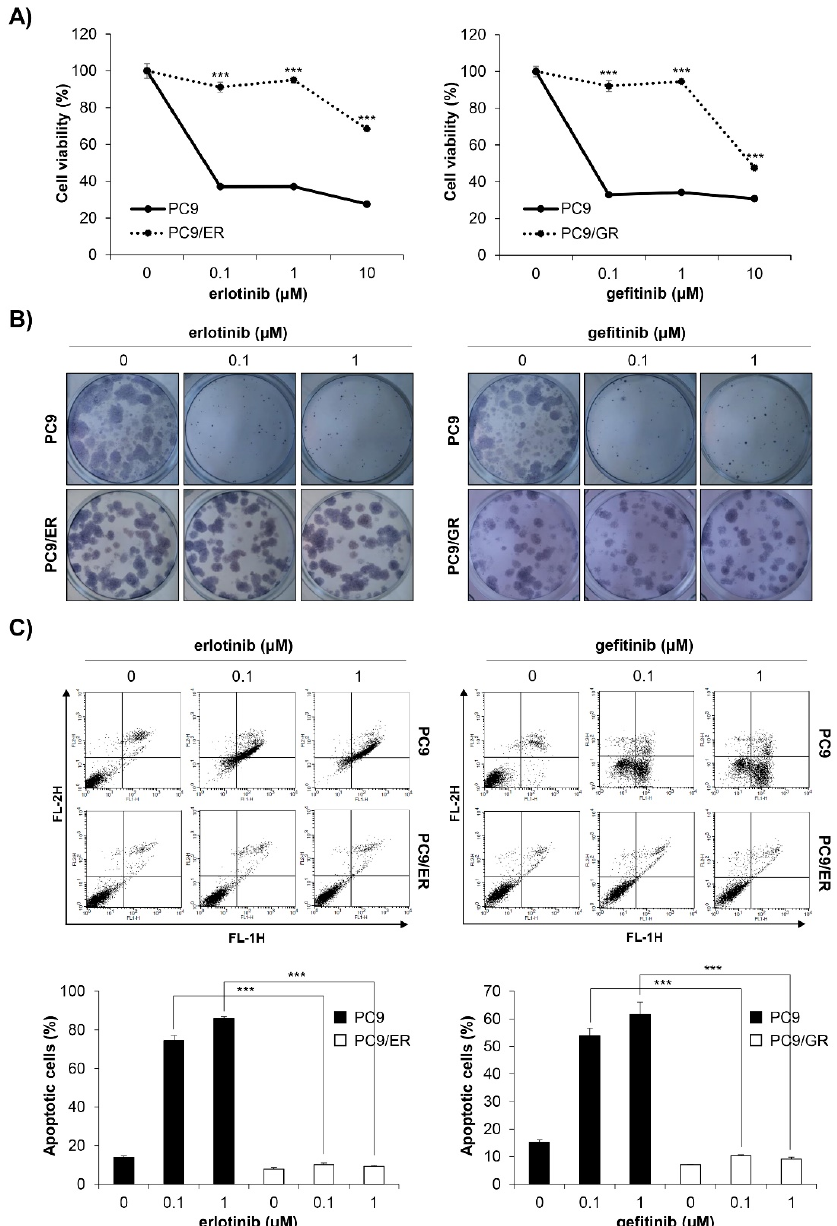
Figure 2. Establishment of PC9/ER and PC9/GR human NSCLC cell lines. ( A ) EGFR TKI-sensitive PC9, acquired erlotinib-resistant PC9/ER, and acquired gefitinib-resistant PC9/GR human NSCLC cell lines were treated with various concentrations of erlotinib (left panel) or gefitinib (right panel) for 72 h. The cell viability was measured by the MTT assay. ( B ) The cells were seeded as a single cell suspension onto 12-well plates and treated with different concentrations of erlotinib (left panel) or gefitinib (right panel) for 10 days. The colonies were photographed using a digital camera (upper panel) and the number of colonies was counted using ImageJ software (lower panel). ( C ) The cells were treated with the indicated concentrations of erlotinib (left panel) or gefitinib (right panel) for 72 h, and the annexin V- and/or PI_stained cells were analyzed by flow cytometry. Representative plot images are shown (upper panel). The percentage of annexin V-positive cells was measured by CellQuest software (lower panel). The data are expressed as the mean ± SD of three independent experiments. Significance was determined by the Student’s t -test (*** p < 0.001 vs. untreated controls). NSCLC, non-small-cell lung cancer; EGFR TKI, Epidermal growth factor receptor tyrosine kinase inhibitor; SD, standard